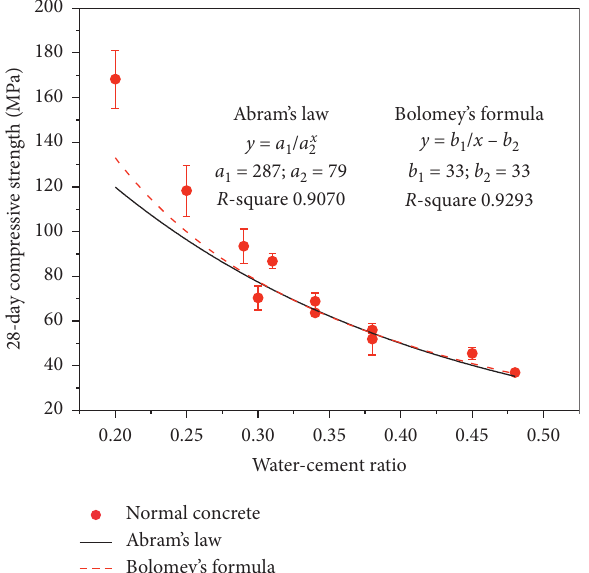
Figure 3: Simulations of Abrams’ law and Bolomey’s formula for normal concrete.